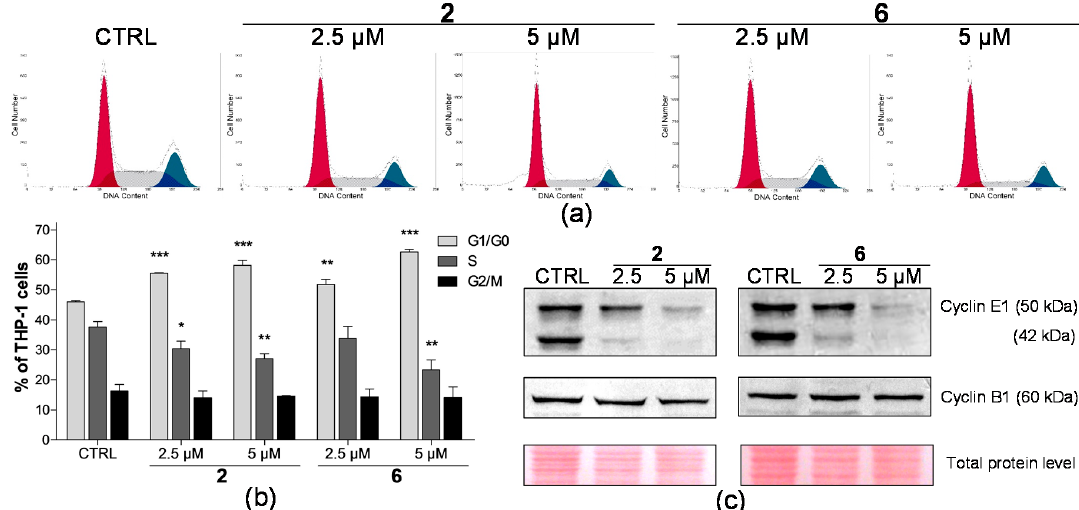
Figure 2. Compounds 2 and 6 induce accumulation of THP-1 cells in the G1 phase. ( a ) Representative histograms of flow cytometric analysis of the DNA content in THP-1 cells after the incubation with indicated concentrations of compounds 2 and 6 for 24 h; ( b ) The distribution of THP-1 cells in the phases of the cell cycle upon the treatment with compounds 2 and 6 at 24 h. The results are expressed as the means ± SD of three independent experiments. * p < 0.05, ** p < 0.01, *** p < 0.001, statistically significant difference in comparison with control sample; ( c ) Expression of cell cycle regulators cyclin E1 and B1 in THP-1 cells treated by compounds 2 and 6 for 24 h, as determined by Western blot analysis. Protein levels of the samples were normalized according to the total protein stains. CTRL, control cells treated by the drug-free medium.